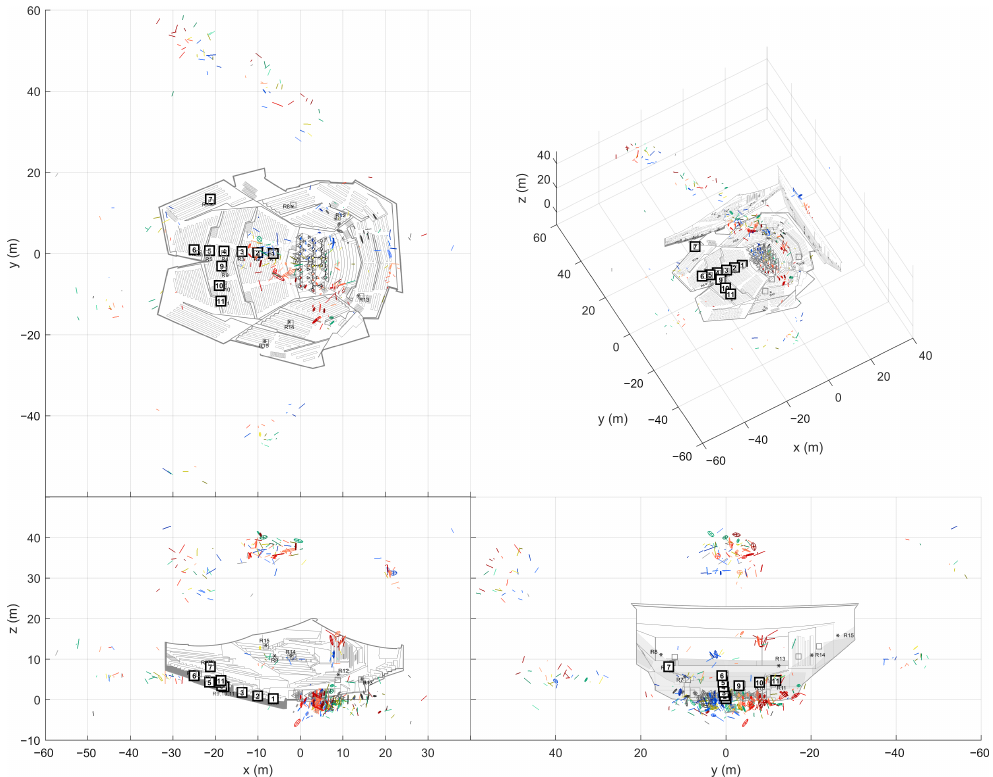
Figure A8. Found image sources for loudspeaker orchestra in Berlin Philharmonie (min. 2 ER objects per image source).